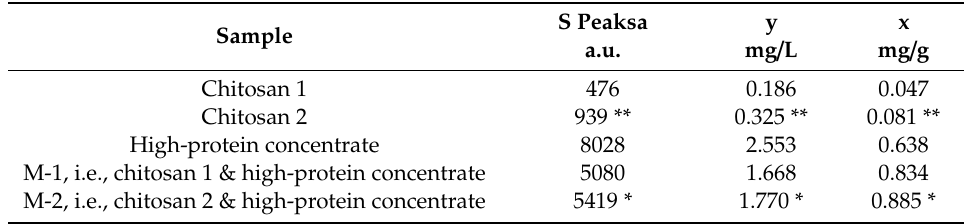
Table 1. Total amount of water-soluble antioxidants (TAWSA) in absolute values and calculated according to the gallic acid standard. Sample